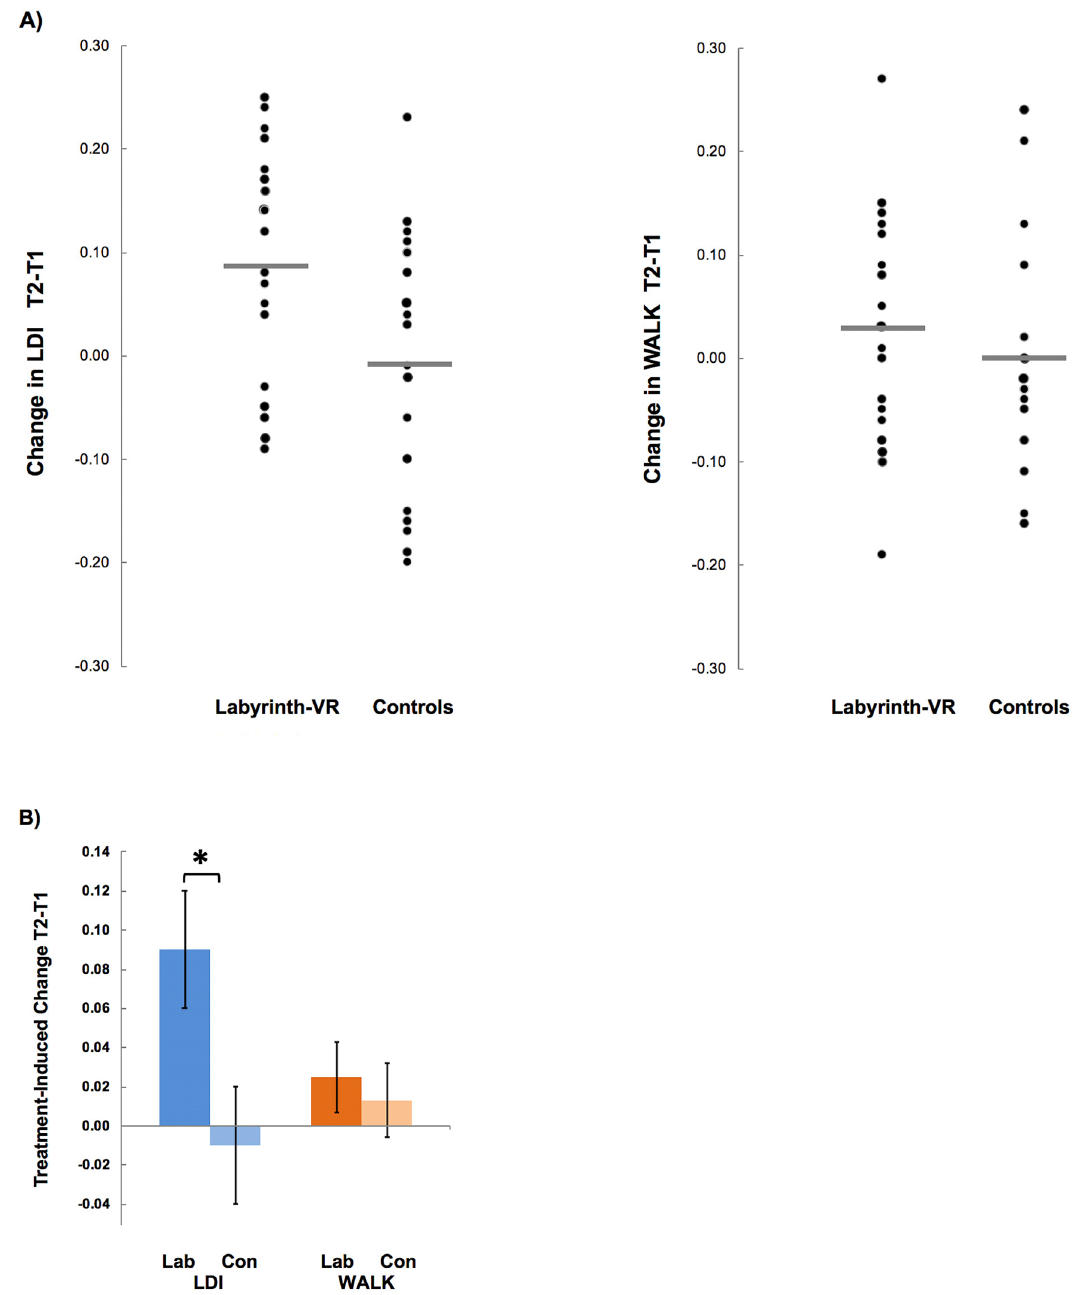
Figure 3. Results for LTM Outcome Measures. (A) The distributions of participants’ individual change scores (i.e., T2-T1) are presented for the Labyrinth-VR and Control arms from the results for Lure Discrimination Index (LDI) and WALK. Mean performance in each column is shown by a horizontal bar. (B) Comparisons of treatment-induced changes between arms showed a robust gain in LDI for Labyrinth-VR (Lab), relative to Control (Con), and a smaller numerical gain in WALK for Lab, relative to Con. * indicates a difference between arms, p <